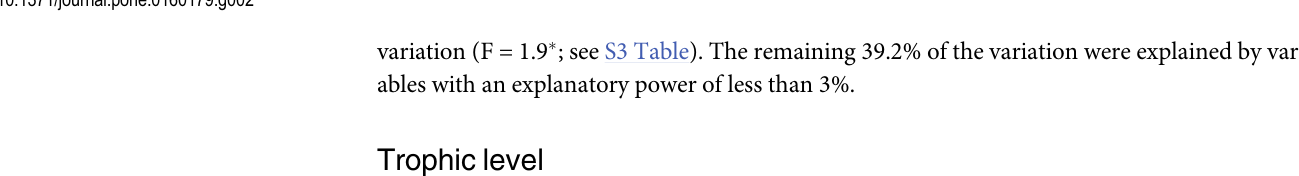
Fig 2. Discriminant function analysis of living testate amoebae in litter (a) and soil (b) of four land-use systems: rainforest (F), jungle rubber (J), rubber (R) and oil palm (O).